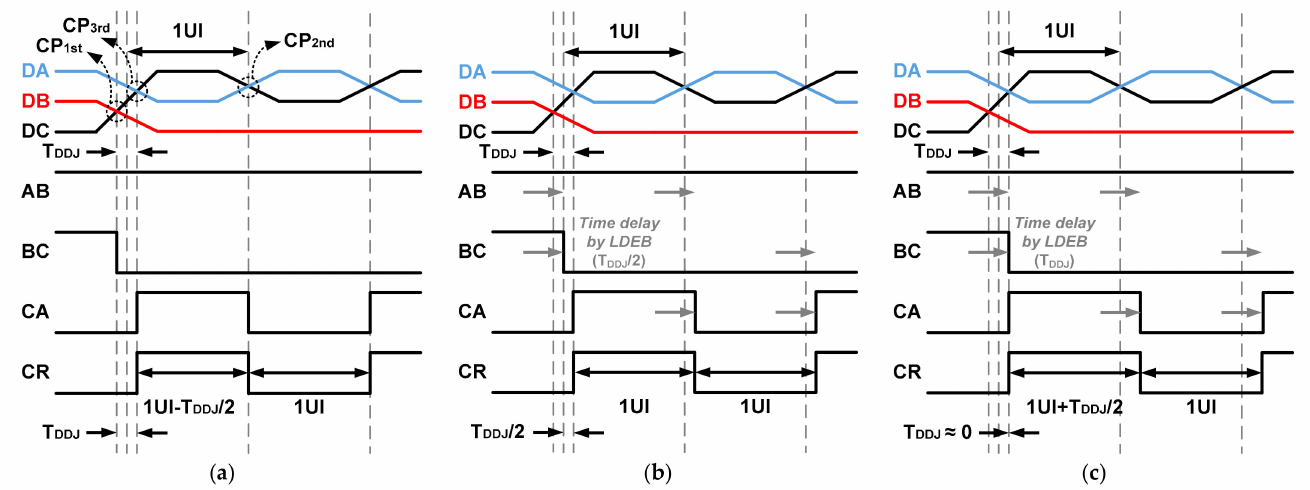
Figure 3. Data-dependent time jitter of data and clock in MIPI C-PHY: ( a ) without LDEB; ( b ) with optimal LDEB; ( c ) with excessive